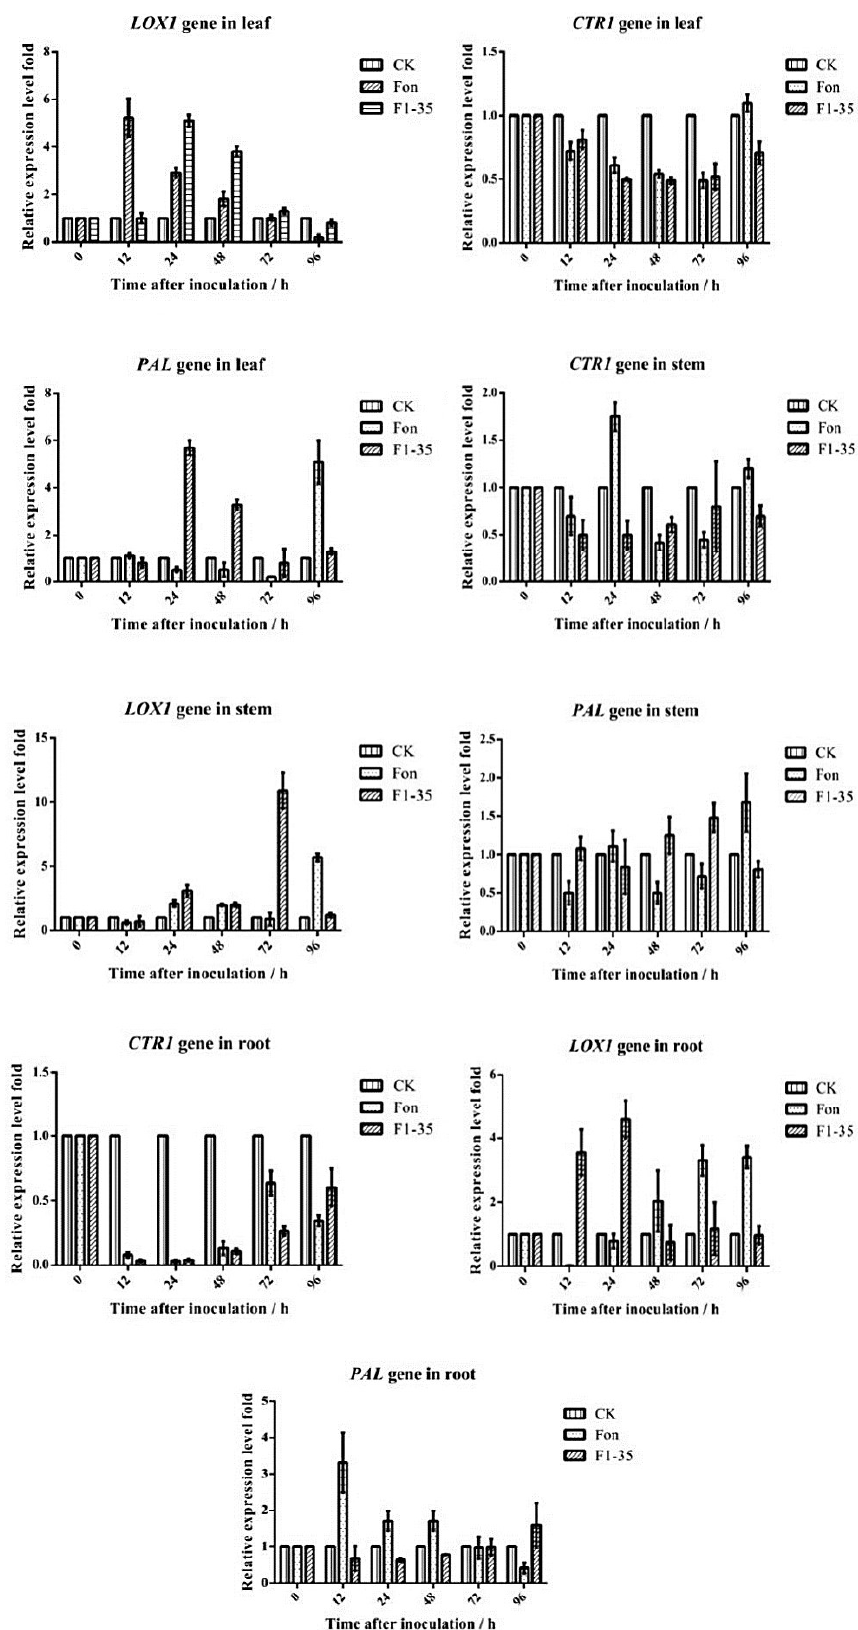
Figure 5. Target gene expression level in the roots, stems, or leaves of plants treated with F1-35 or